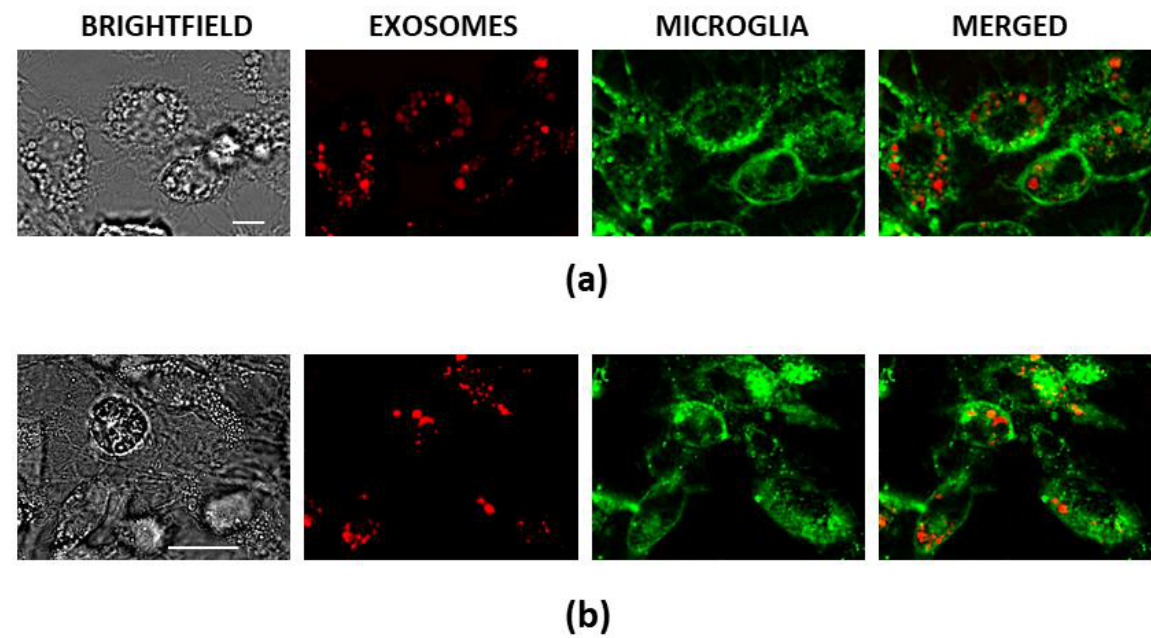
Figure 5. Poly (I:C)-treated airway cell ELV internalisation by microglia in and in pure microglial ( a ) and mixed rat ( b ) glial cultures 30 min after treatment. Particles loaded with RNR-conjugated AF555 are red, nuclei are stained blue with Hoechst33342, and microglial cells are green, stained with AF488-conjugated isolectin B4. The scale bar in ( a ) is 10 µ m and in ( b )—50 µ m.